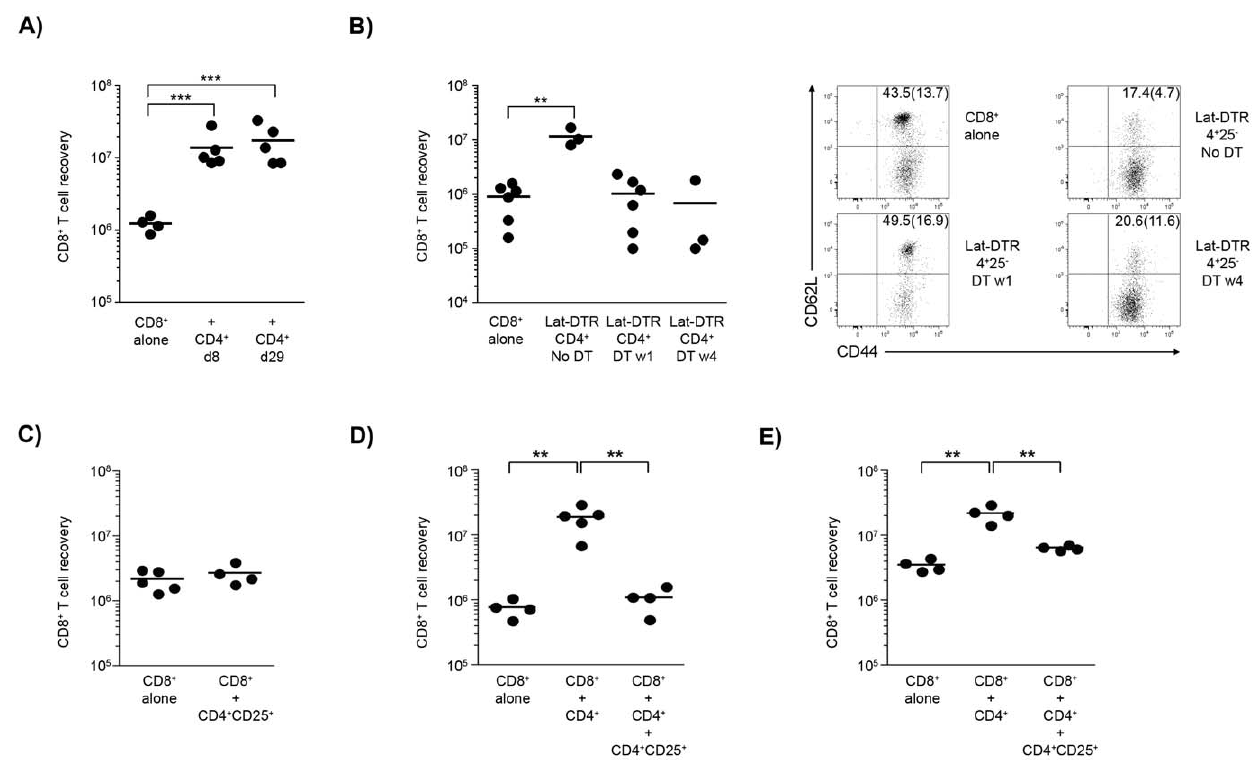
Figure 3. Time requirements of T cell help and the role of T regs cells. ( A ) 2 6 10 4 CD8 + T cells were transferred into CD3 e 2 / 2 hosts. At 8 or 29 days after groups of hosts received CD4 T cells (2 6 10 4 cells) and the mice were sacrificed 7 weeks after the first cell transfer. The mean CD8 + T cell recovery is shown for the three groups of hosts (*** p # 0.001). It should be pointed out that the late transfer of CD4 T cells still induced the preferential accumulation of CD62L low CD8 + T EM cells (not shown) ( B ) 2 6 10 4 CD8 + T cells were transferred alone or with CD4 + T cells from Lat-DTR mice into a CD3 e 2 / 2 host. A fraction of the mice were treated with diphtheria toxin (DT) for 10 days at either one or 4 weeks after cell transfer, and the mice were analyzed 7 weeks after cell transfer. The number of CD8 + T cells recovered 7 weeks after cell transfer is shown. CD4 + T cell depletion at week 1 or at week 4 reduced the number of CD8 + T cells recovered (** p # 0.01). Similar findings were obtained in two independent experiments. Dot plots show representative examples of the CD62L and CD44 expression by the CD8 + T cells recovered in the different groups of mice. ( C ) 10 4 CD8 + T cells were transferred into CD3 e 2 / 2 hosts alone or with 5 6 10 4 CD4 T reg cells. The number of CD8 + T cells recovered in individual mice is given as the mean value for each group. ( D ) 10 4 CD8 + T cells were transferred into CD3 e 2 / 2 immune-deficient hosts alone, co-transferred with 10 4 CD4 naive T cells or co-transferred with 10 4 CD4 naive T cells and 5 6 10 4 CD4 T reg cells in three independent groups of hosts. The number of CD8 + T cells recovered in individual mice is given as the mean value for each group. The increased expansion of CD8 + T cells seen upon co-transfer with CD4 naive T cells was abolished when the T reg cells were added in the transferred mix. (** p # 0.01) ( E ) 10 5 total CD8 + T cells were transferred into CD3 e 2 / 2 hosts alone, co- transferred with 10 4 CD4 naive T cells or co-transferred with 10 4 CD4 T cells and then given 5 6 10 4 T reg cells four weeks latter. Mice were culled 8 weeks after the initial CD8 + T cell transfer. The data indicate the number of CD8 + T cells recovered in each host. Statistically significant differences are shown (** p , 0.01). Similar findings were obtained in two independent